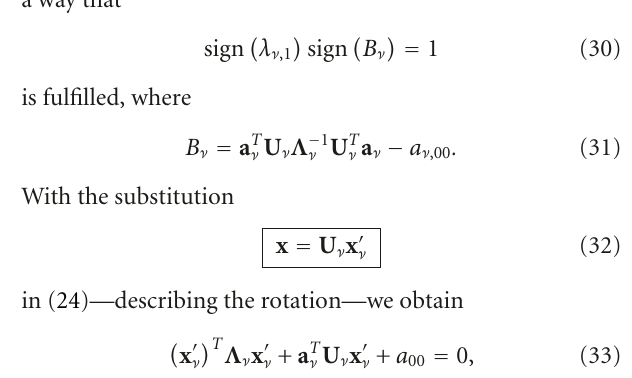
Figure 4: Hyperbola